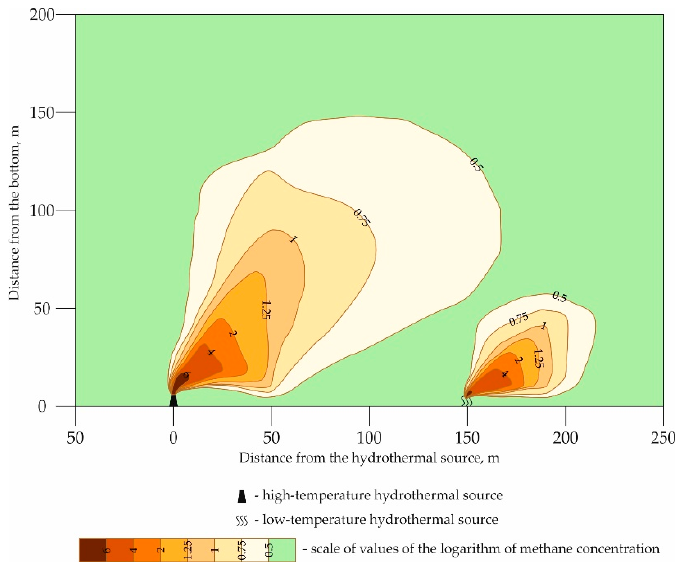
Figure 14. The schematic structure of the methane anomaly over hydrothermal vents based on the results of sounding over the Logachev, Koralovoye and Molodezhnoye fields.